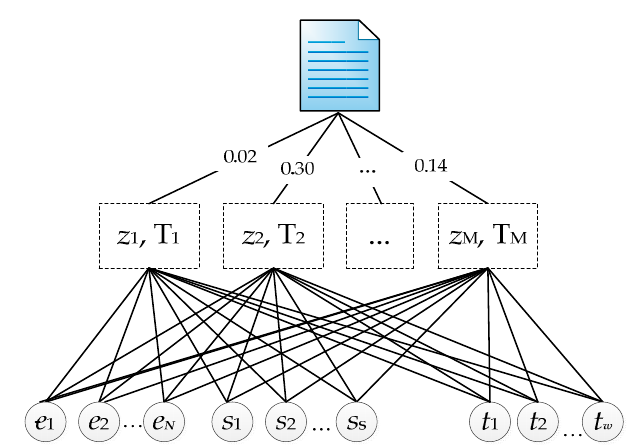
Figure 4. The components of D r .